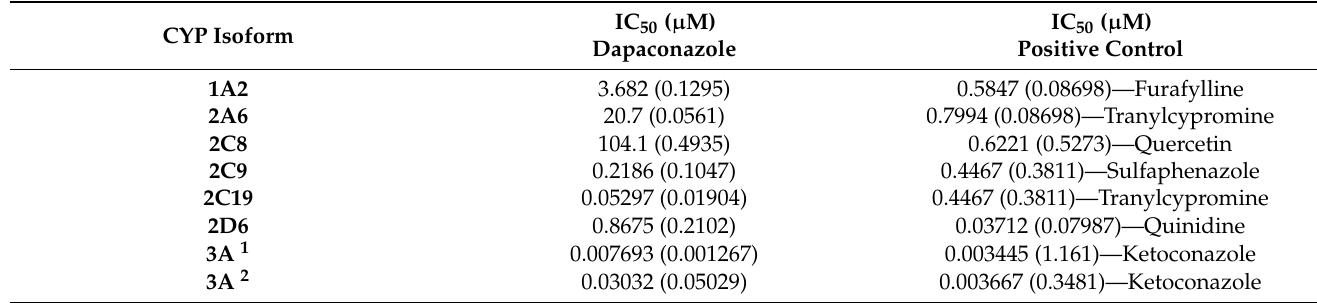
Table 3. IC 50 values obtained from the in vitro CYP450 metabolism inhibition